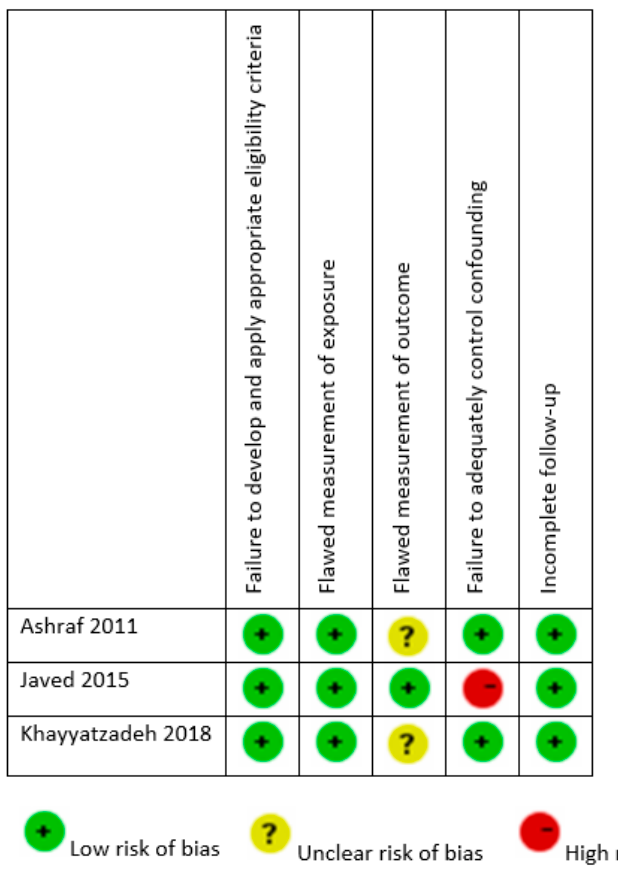
Figure 2. Risk of bias of non-randomized human interventions studies.